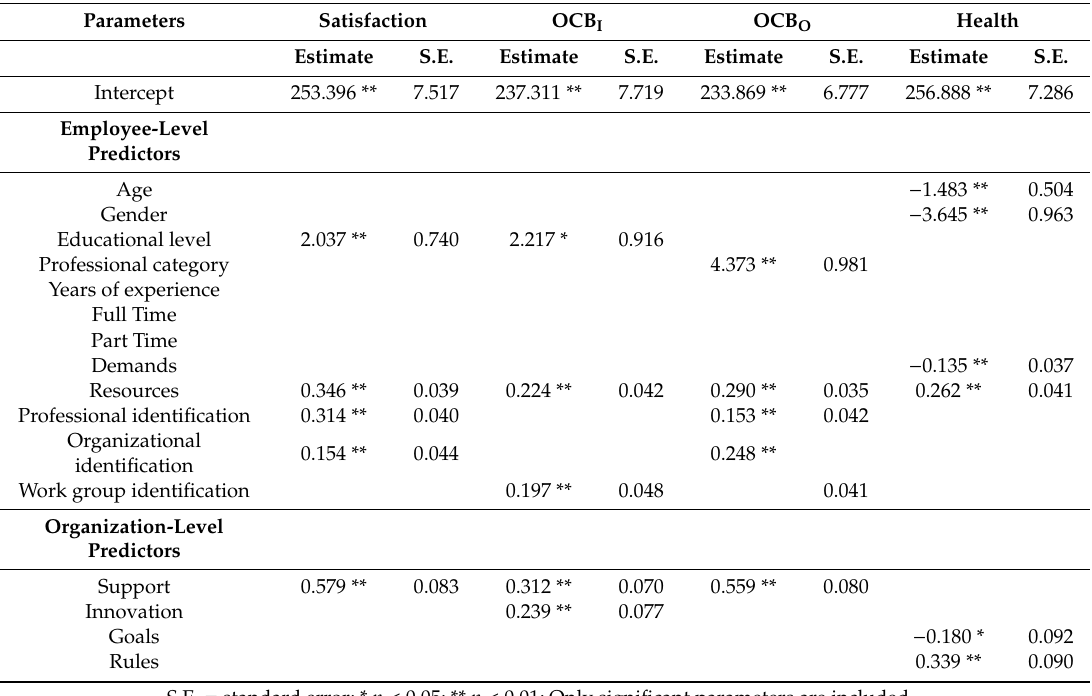
Table 3. Fixed part of the